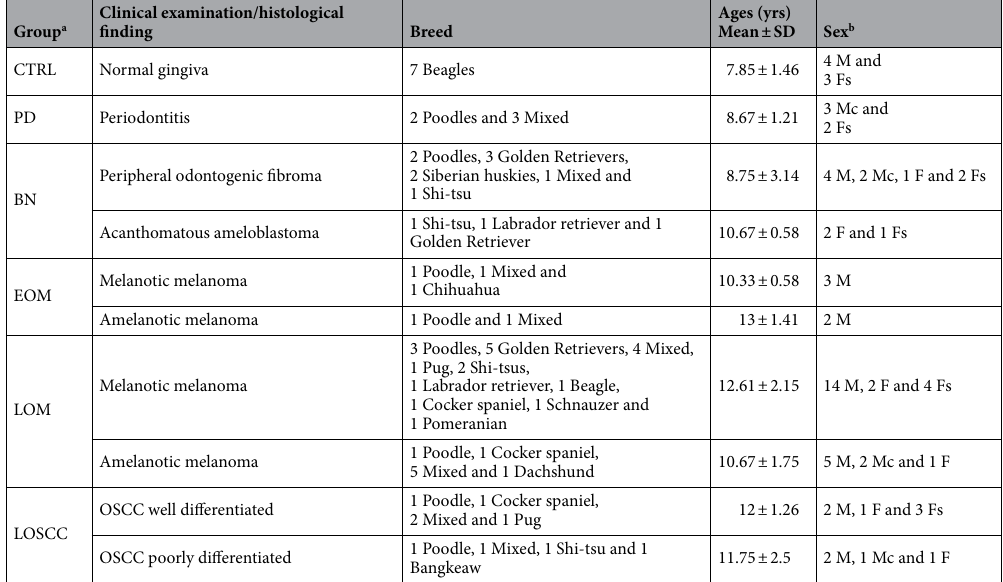
Table 2. Patients’ history. a CTRL control, PD periodontitis, BN benign tumors, EOM early-stage oral melanoma, LOM late-stage oral melanoma, LOSCC late-stage oral squamous cell carcinoma. b M male, Mc male castration, F female, Fs female